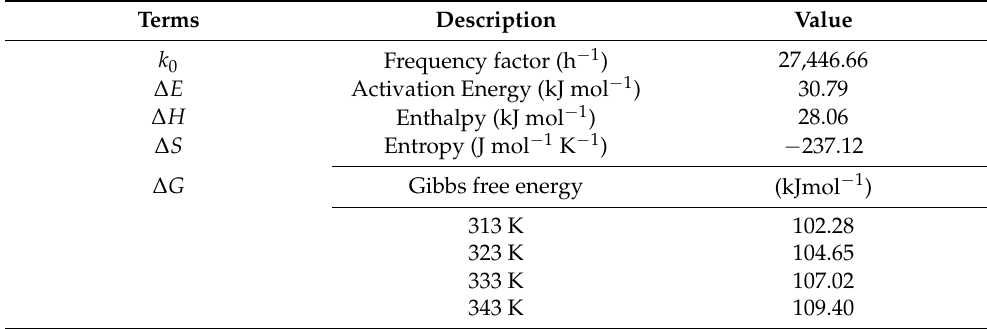
Figure 7. ( a ) The Eyring plot (1/ T vs ln k / T ); ( b ) A plot of ∆ G vs. T of used catalyst-based transesteri- fication reaction. Table 6. Different thermodynamic parameters with calculated values of the transesterification